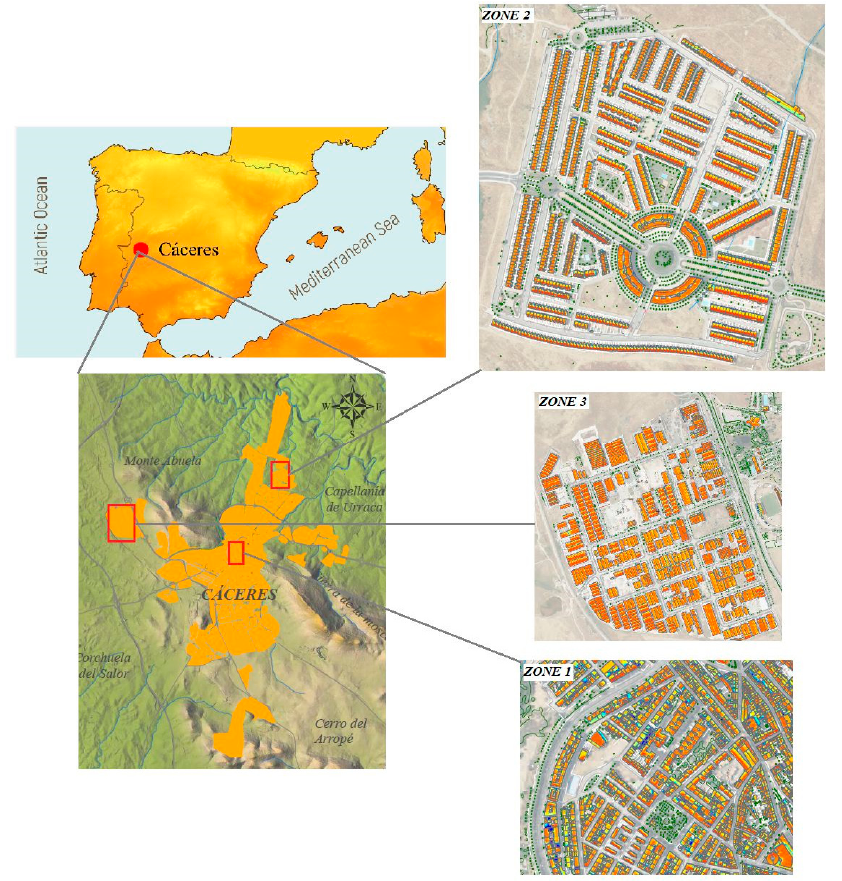
Figure 1. Working area and distribution of the three studied neighborhoods.